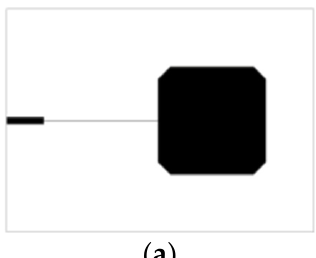
Figure 5. ( a ) The metallization mask. ( b ) The doping mask.